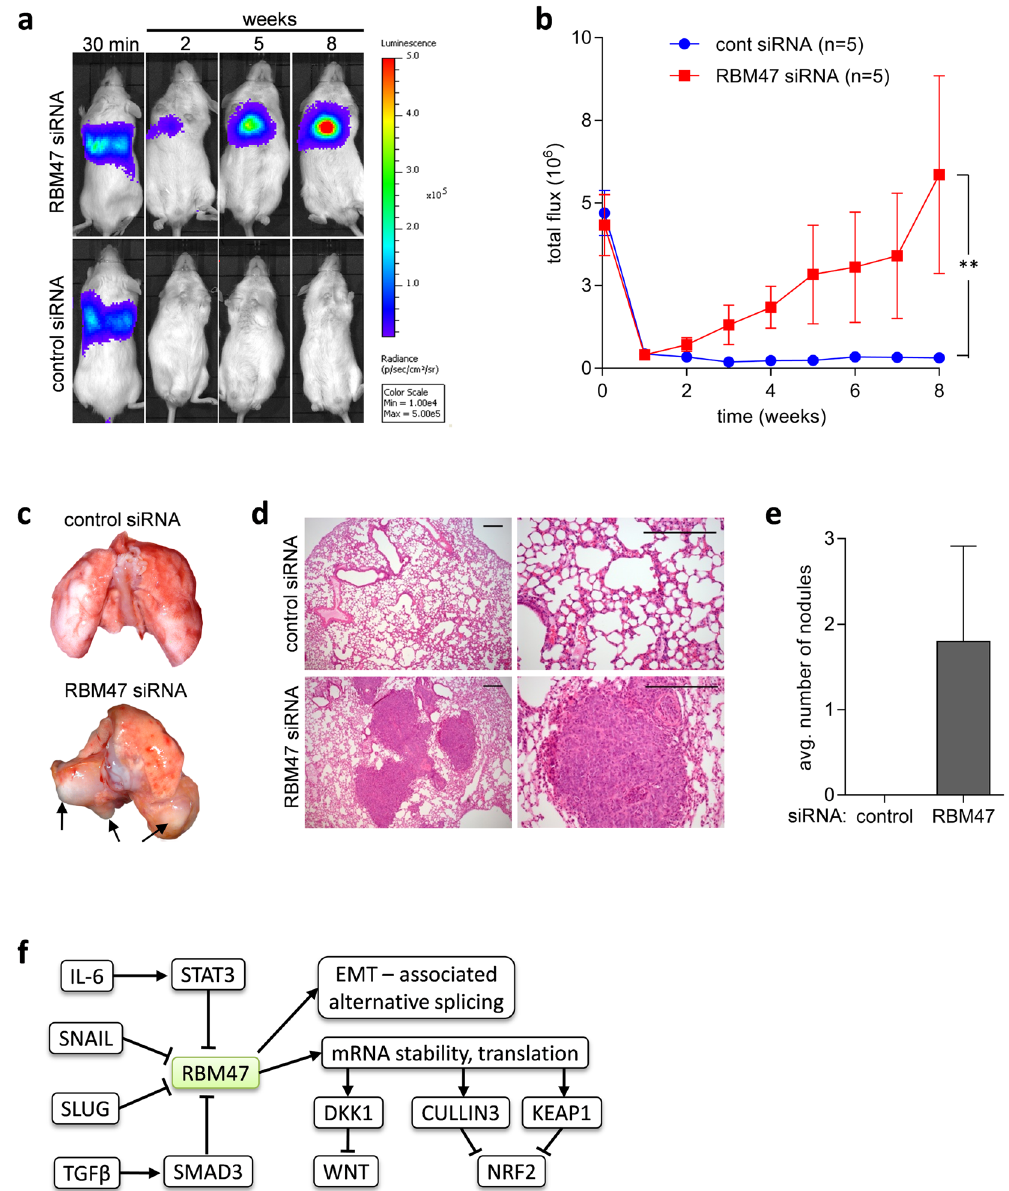
Figure 8. Inhibition of RBM47 induces metastasis. Formation of lung metastases after tail-vein injection of DLD-1–Luc2 cells transfected with control or RBM47 -specific siRNA. ( a ) Representative images of luciferase signals after D-luciferin injection at the indicated time points after xenografting. ( b ) Weekly measurements of total photon flux. Results are the mean ± SD (n = 5). ** P < 0.01. ( c ) Representative lungs 8 weeks after tail vein injection. ( d ) H&E staining of lung tissue. Scale bars represent 500 μ m. ( e ) Number of metastatic nodules in lungs 8 weeks after tail vein injection of the indicated DLD1 cells into mice (n = 5). ( f ) Model of regulation of RBM47 expression and its downstream targets, which presumably mediate its effects on EMT and cancer